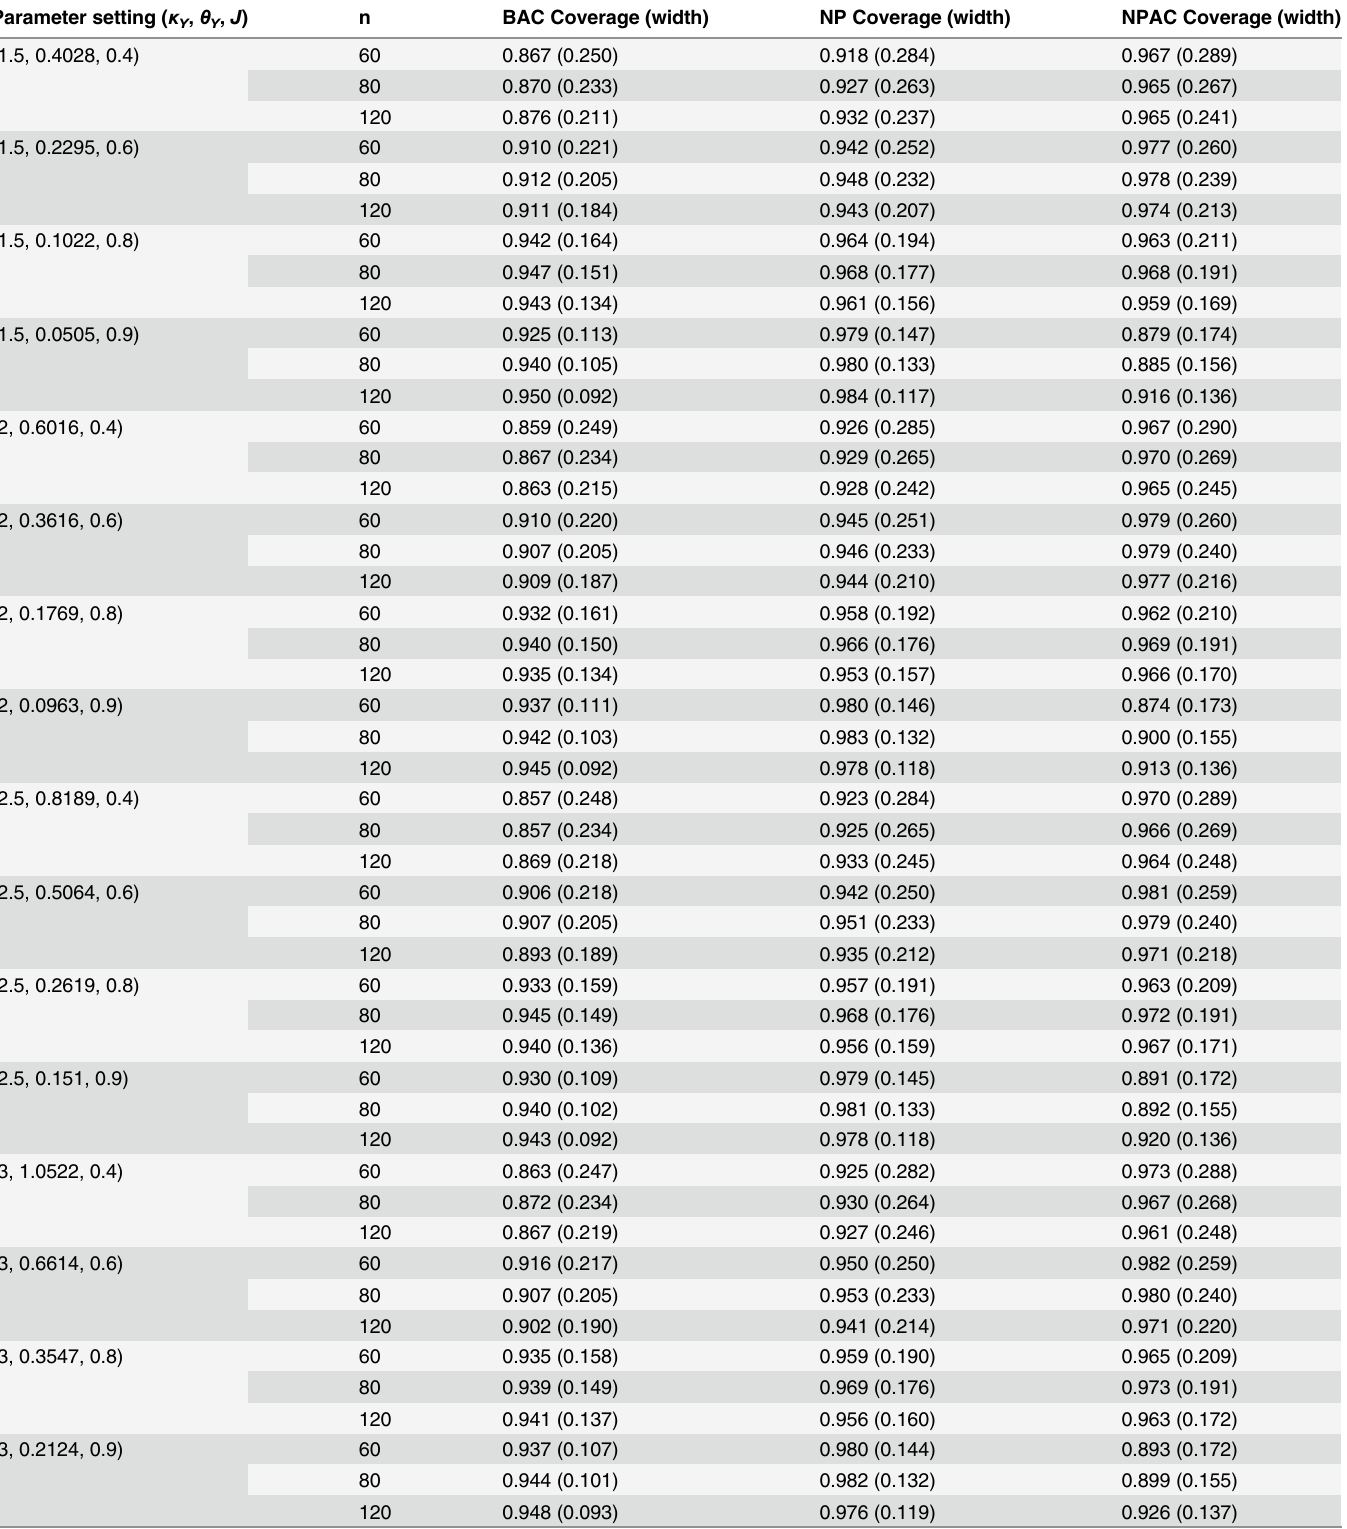
Table 8. Gamma distributions: coverage probabilities and average widths when m = 80 in the non-diseased group at the 95% nominal